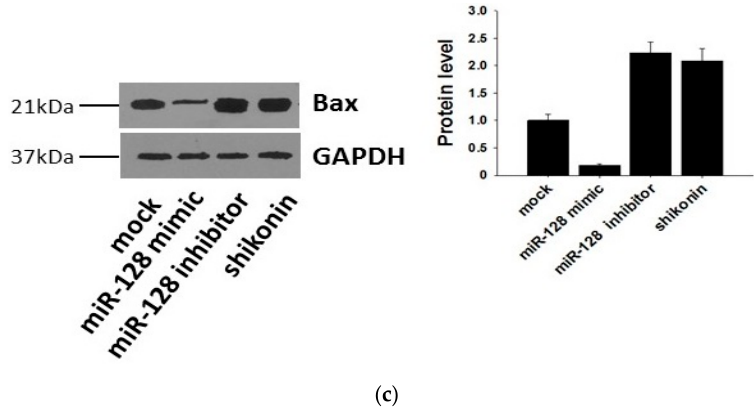
Figure 5. Bax was negatively regulated by exosomal miR-128 in MCF-7 recipient cells. ( a ) MiR-128 levels in secreted exosomes; ( b ) qRT-PCR detection of Bax mRNA in MCF-7 recipient cells after incubation with miR-128 knockdown/over-expressive or shikonin (1 µM treated for 24 h) treated exosomes; ( c ) Protein levels of Bax were detected by western blotting (left panel), and quantitative analysis of the western blotting result is shown in the right panel.